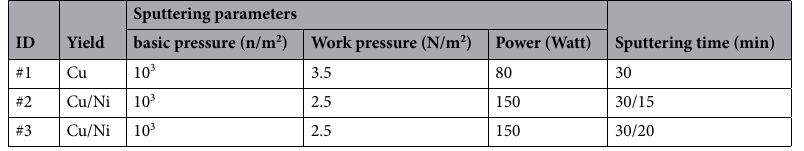
Table 1. Details and ID of prepared